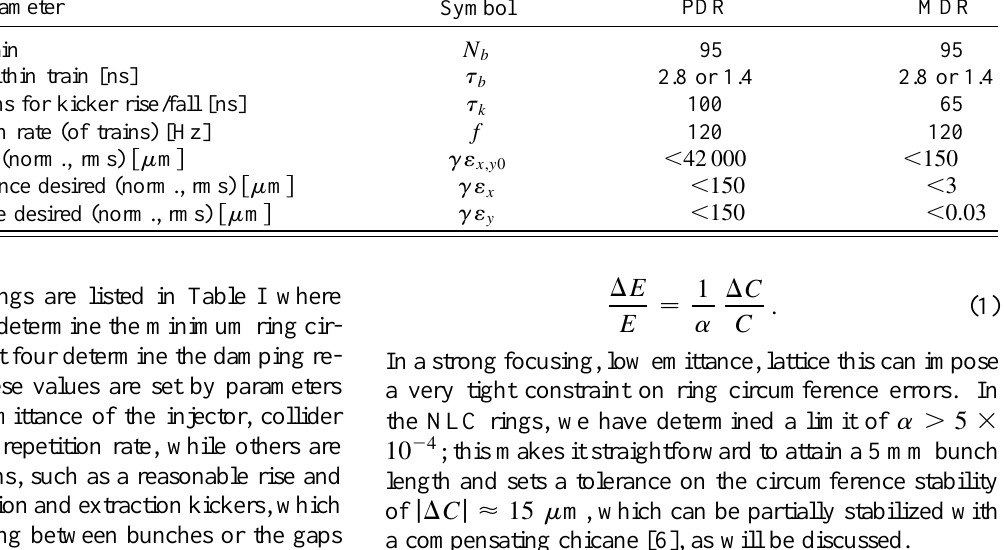
TABLE I. Parameters which determine the minimum circumference and damping requirements of the ring. The values listed here are for the NLC e 1 (cid:1) e 2 MDR and the e 1 PDR. Parameter Symbol PDR MDR Number of bunches per train N b 95 95 Bunch to bunch spacing within train [ns] t b Minimum gap between trains for kicker rise/fall